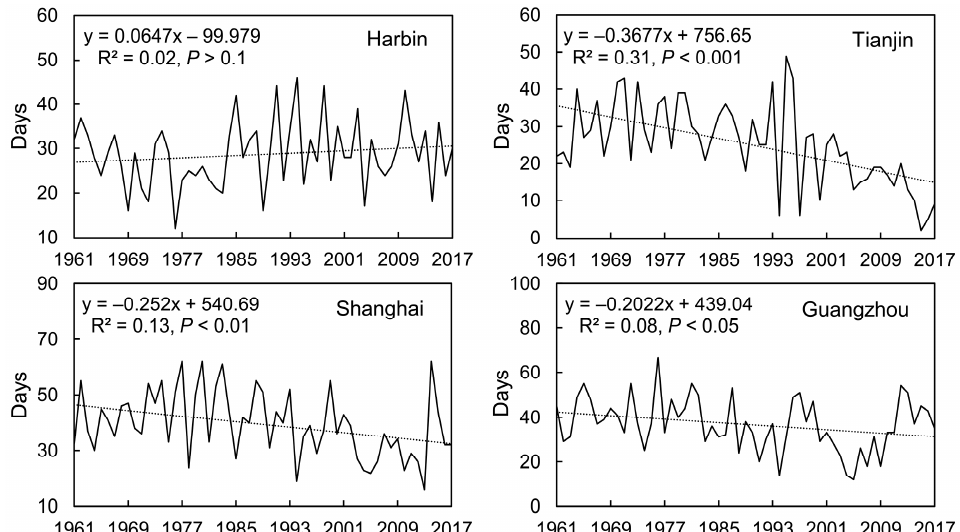
Figure 4. Changes in dehumidification degree days during the period of 1961–2017 for the four se- lected cities.